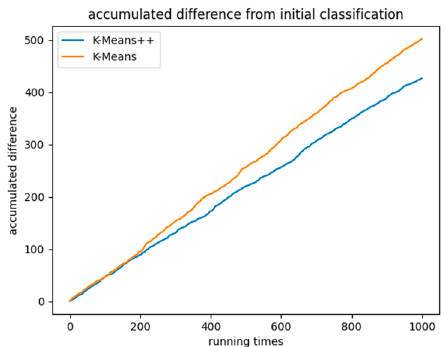
Figure 9. Accumulated difference of two clustering algorithms. Table 2. Results of K-Means++ clustering for all samples.